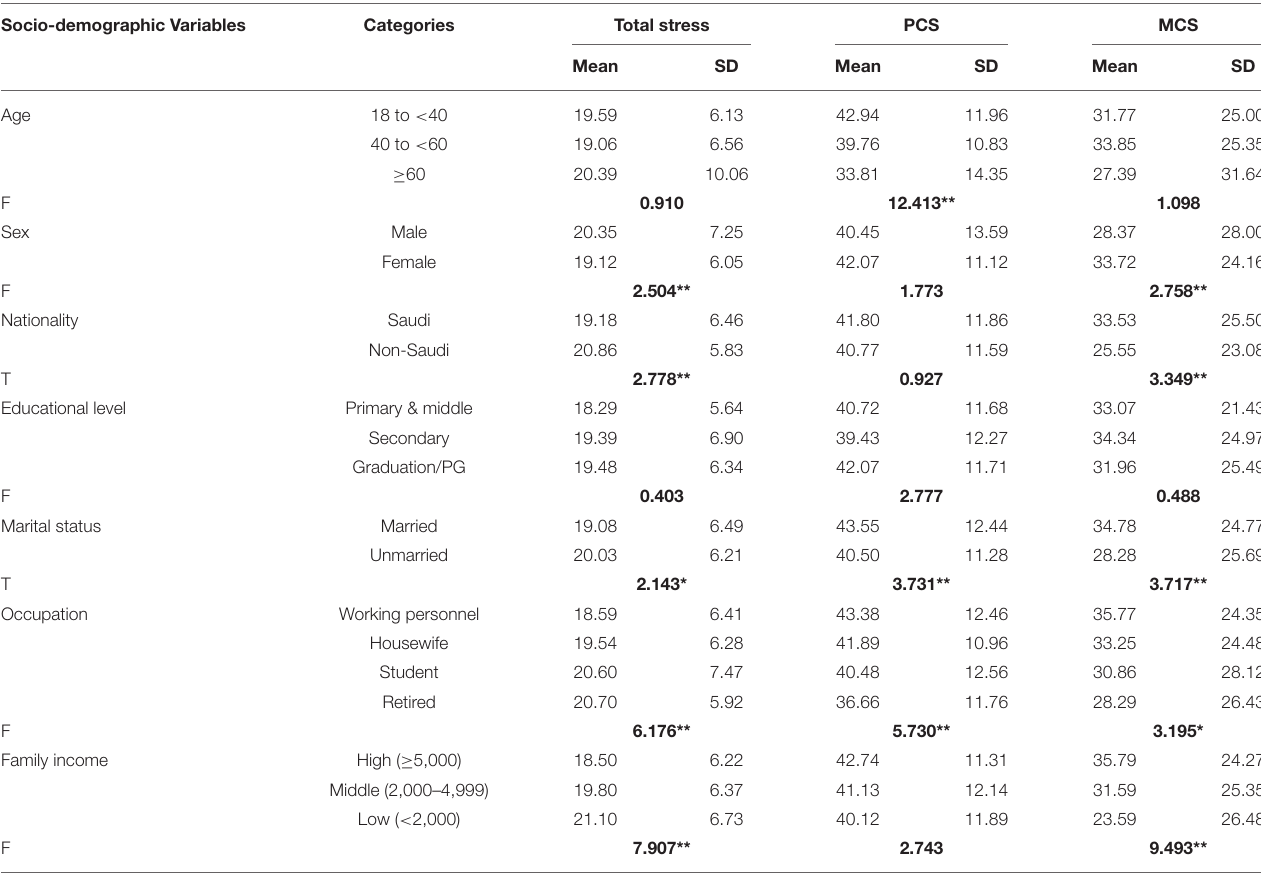
TABLE 6 | Mean, and difference among COVID-19 total stress, PCS, MCS & sociodemographic characteristics of the study participants ( N = 878). Socio-demographic